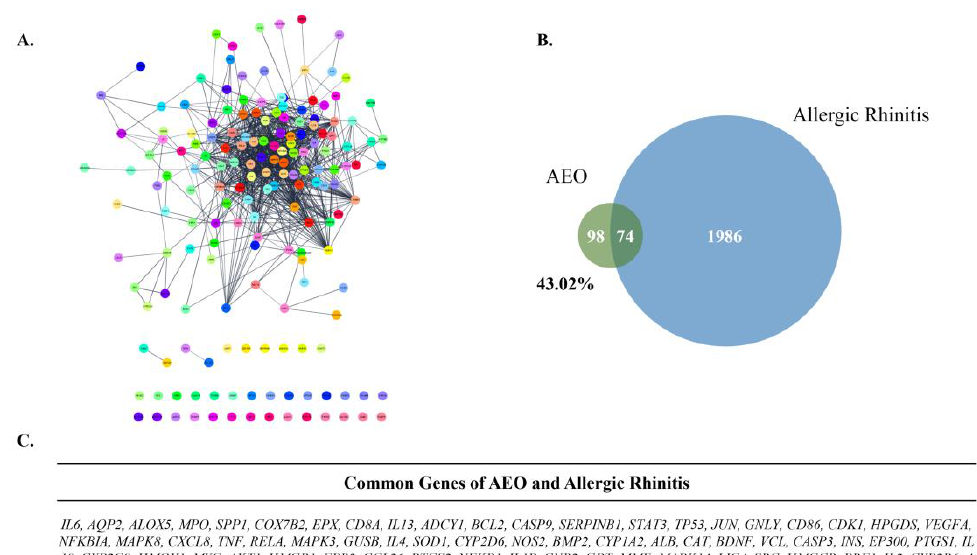
Figure 1. Network analysis of AEO. ( A ) PPIN of AEO. ( B ) Venn-diagram of AEO and Allergic Rhinitis gene set. ( C ) Common genes of AEO and allergic rhinitis gene set.